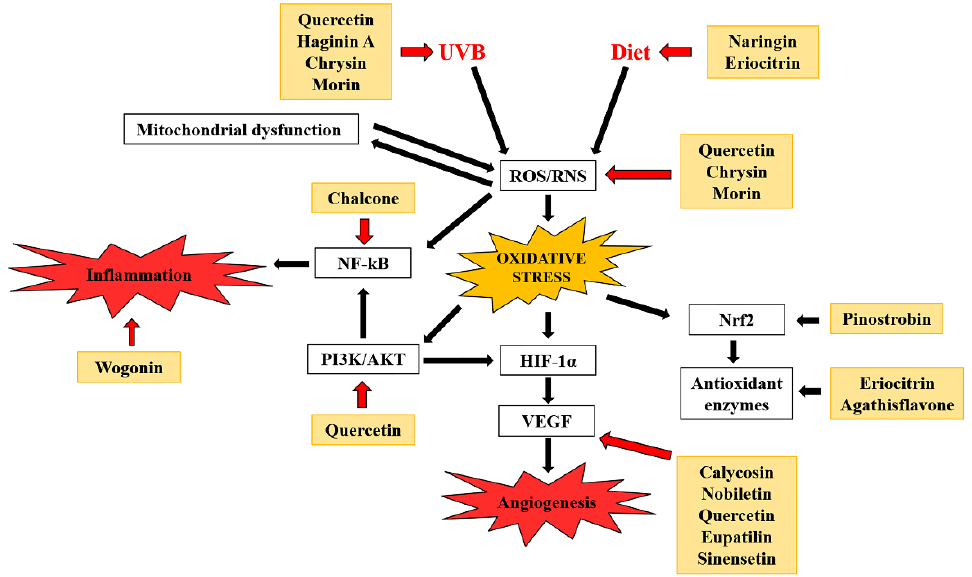
Figure 4. Molecular mechanisms underlying flavonoid action against oxidative stress disorders. Black and red arrows indicate induction and inhibition, respectively.